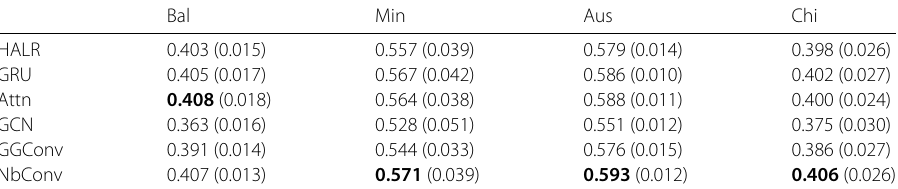
Table 5 Average (standard deviation) of monthly F1 score using C + M for property crime prediction from Aug. to Dec. 2020 for each city Bal Min Aus Chi HALR 0.403 (0.015) 0.557 (0.039) 0.579 (0.014) 0.398 (0.026) GRU 0.405 (0.017) 0.567